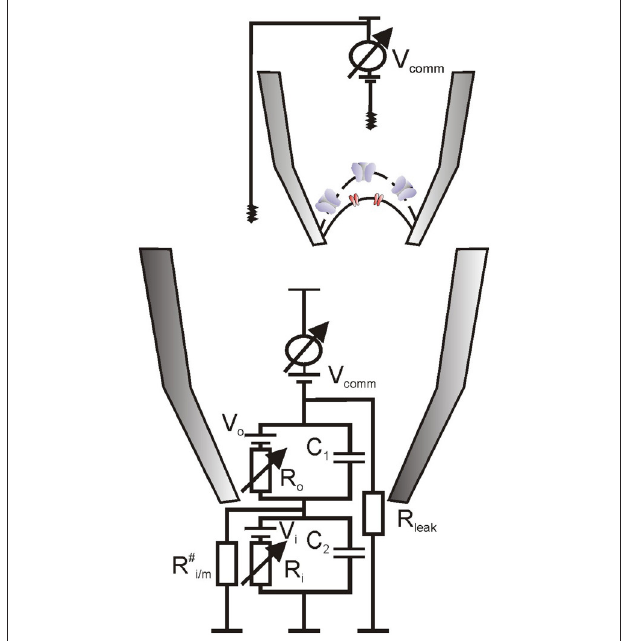
FIGURE 2 | Hypothetical equivalent electrical circuit for recording on a sandwich-like envelope patch. It is assumed that the intermembrane space was tightly sealed (R # i / m >> R o ) and that inner envelope electrical resistance was much higher than of the outer envelope, R i >> R o (due to the presence of multiple porins in the latter), so that command voltage (V comm ) dropped almost entirely across the inner envelope membrane patch (V comm ∼ V i ). R o represents the access resistance, which was ∼ 1 GOhm for measurements on pea chloroplasts, equivalent to a presence of few (2–3) open porins in the outer patch membrane. Average patch capacitance was about 0.35 pF; on the basis of specific capacitance for biological membranes ( ∼ 1 µ F/cm 2 ) this transforms to 35 µ m 2 or 70% of the pea chloroplast surface, additional argument for the presence of a double membrane vesicle in the patch (Pottosin et al.,